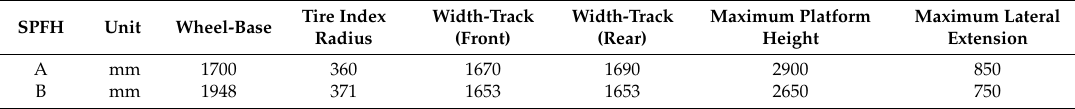
Table 3. Main characteristics of the SPFHs adopted for the laboratory